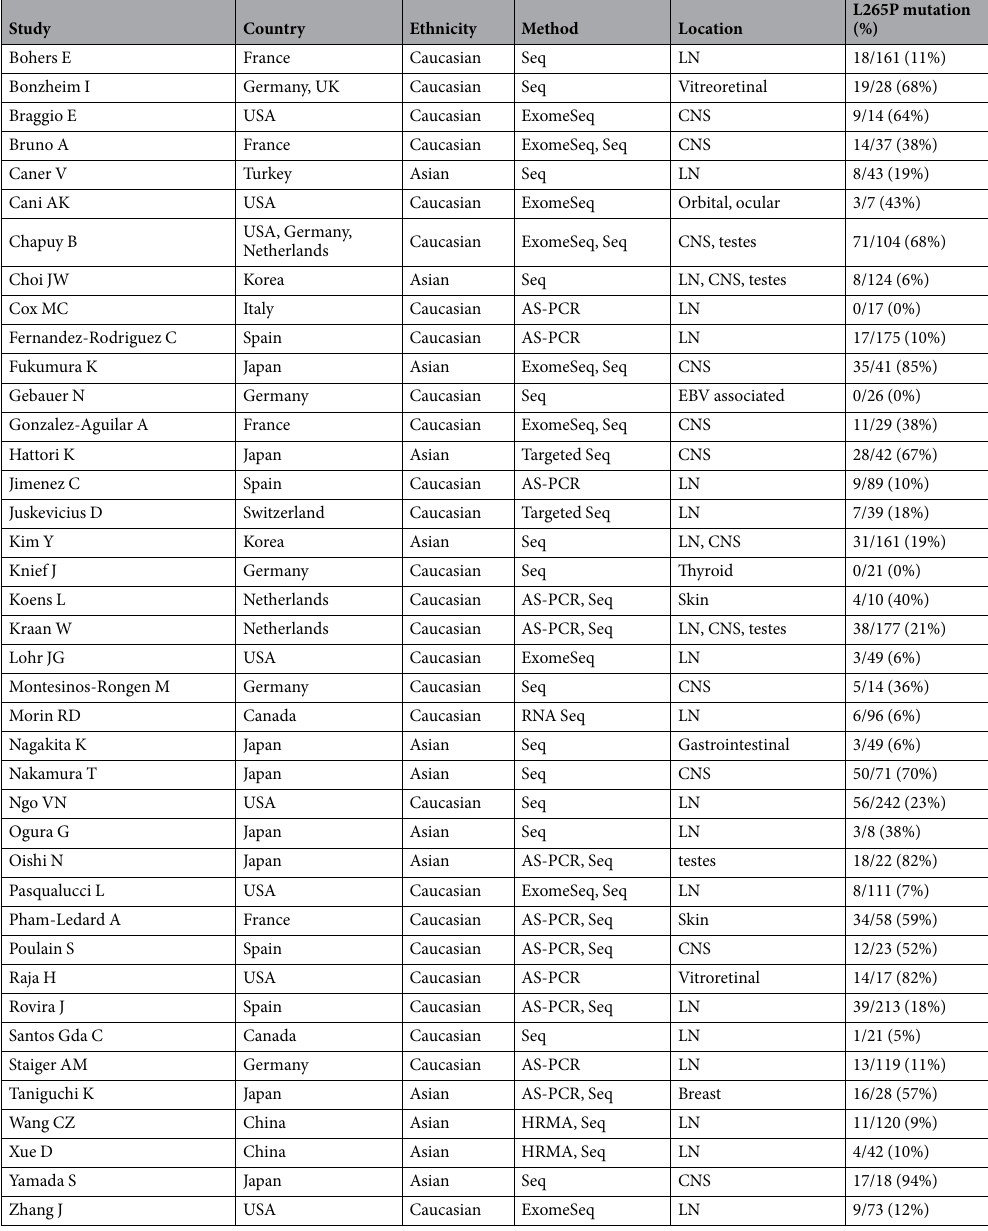
Table 1. Characteristics of individual studies of MYD88 L265P mutation in diffuse large B-cell lymphoma patients. Seq; sequencing, AS-PCR; allele-specific polymerase chain reaction, HRMA; high resolution melting analysis, LN; lymph node, CNS; central nervous system, EBV; Epstein-Barr